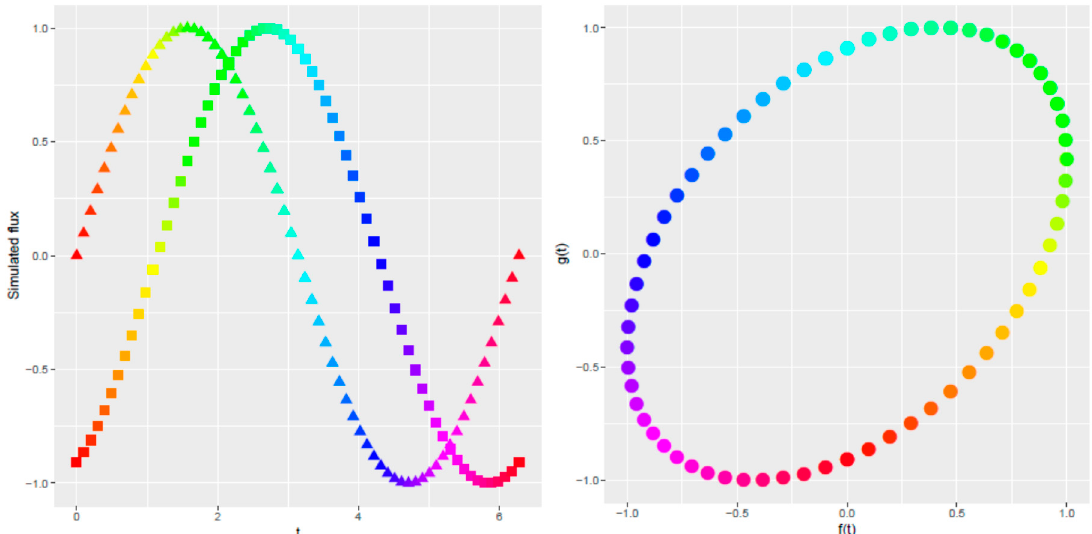
Figure 2. Idealized catchment flux system ( left , input shown with triangles, output shown with squares) over time (color), and corresponding idealized response ellipse ( right ).